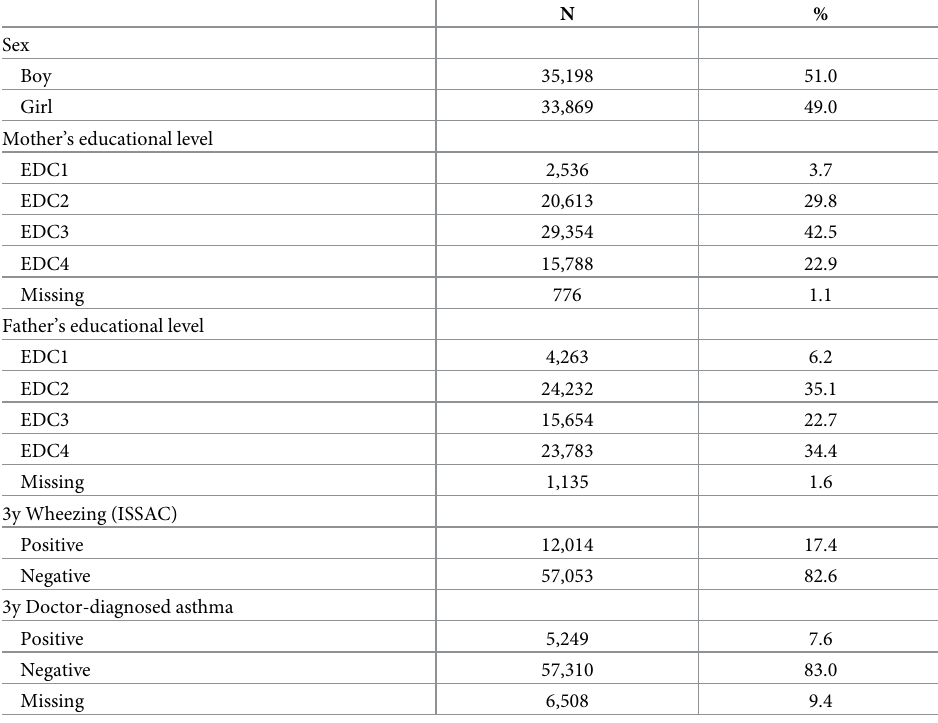
Table 1. Child sex, mothers’ and fathers’ educational levels, and outcomes. (N = 69,067).